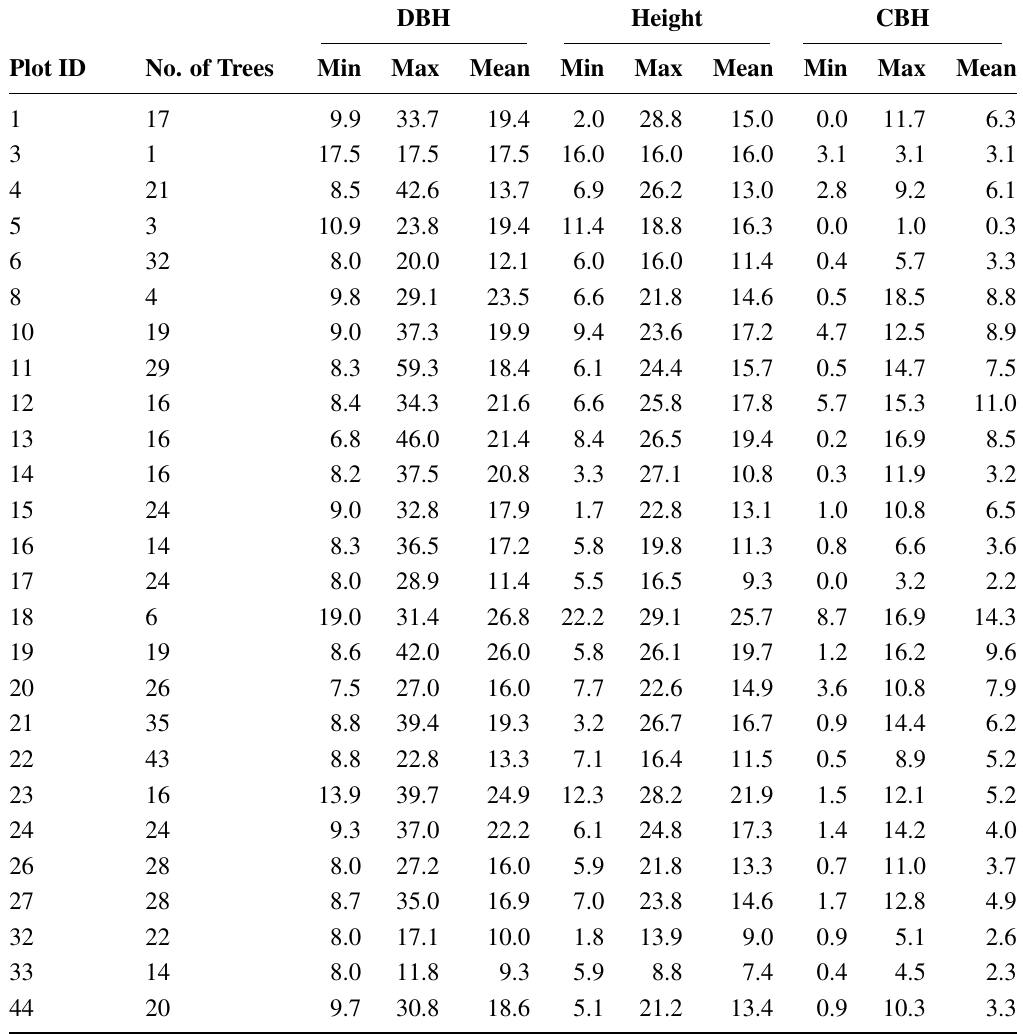
Table 1. Summary of field plots used in this study. The mean value for canopy base height (CBH) is based on live trees in each plot. DBH Height CBH Plot ID No. of Trees Min